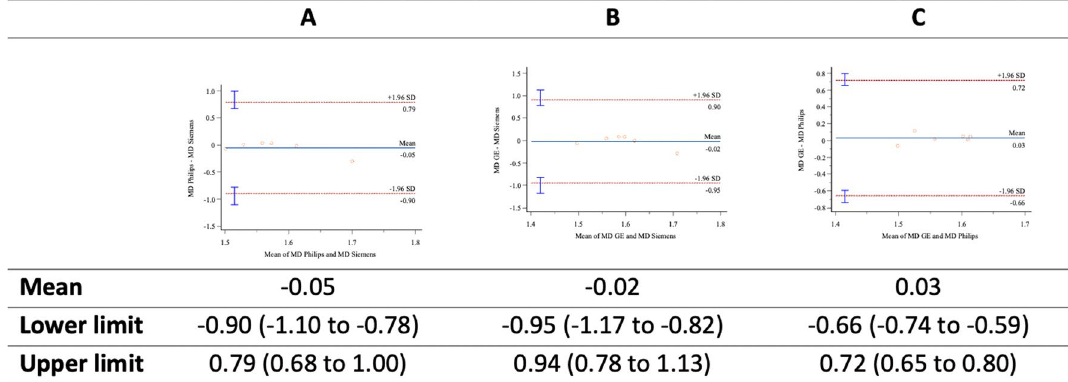
Fig. 3 MD- A : Philips versus Siemens; B : GE versus Siemens; C : GE versus Philips